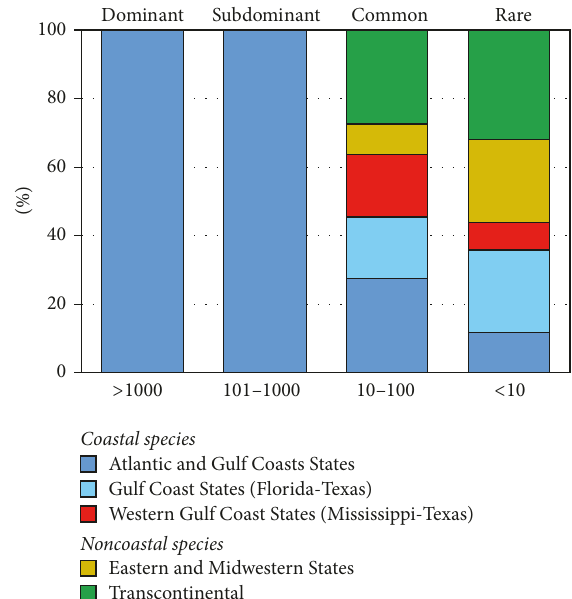
Figure 2: Stacked bar chart showing the range-abundance pattern of the members of Auchenorrhyncha and Heteroptera, collected in Louisiana salt marshes in the Mississippi Delta. 𝑋 -axis represents classes of abundance with corresponding species group names and a number of collected specimens per species. Comments in the